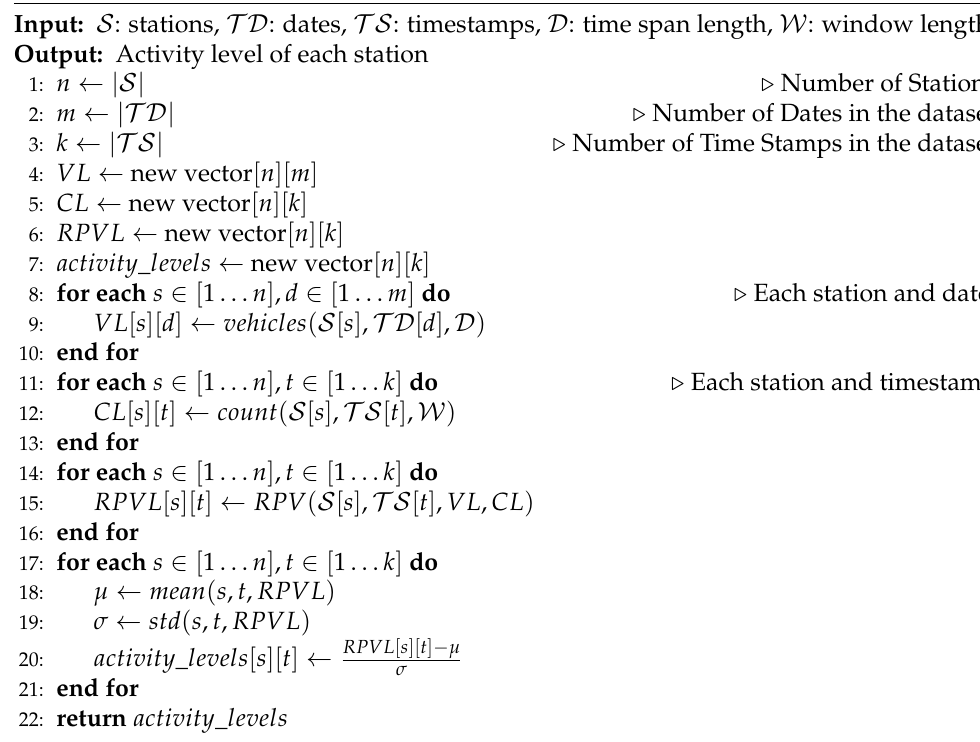
Algorithm 2 Activity level estimation